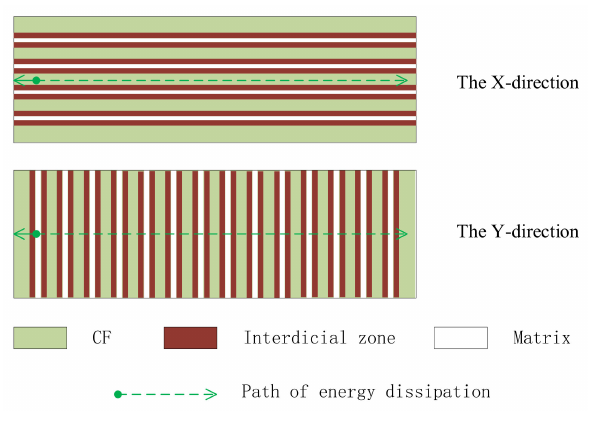
Figure 10. Diagram of energy